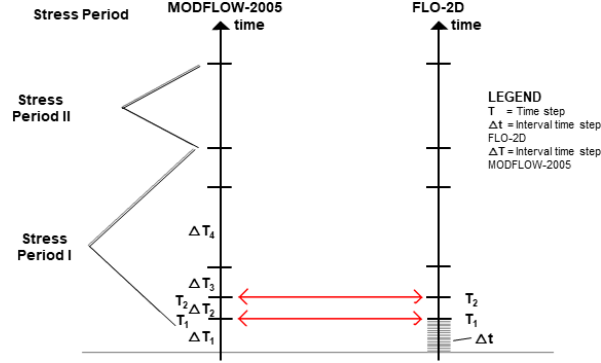
Figure 5. Time step synchronization of FLO-2D and MODFLOW- 2005.